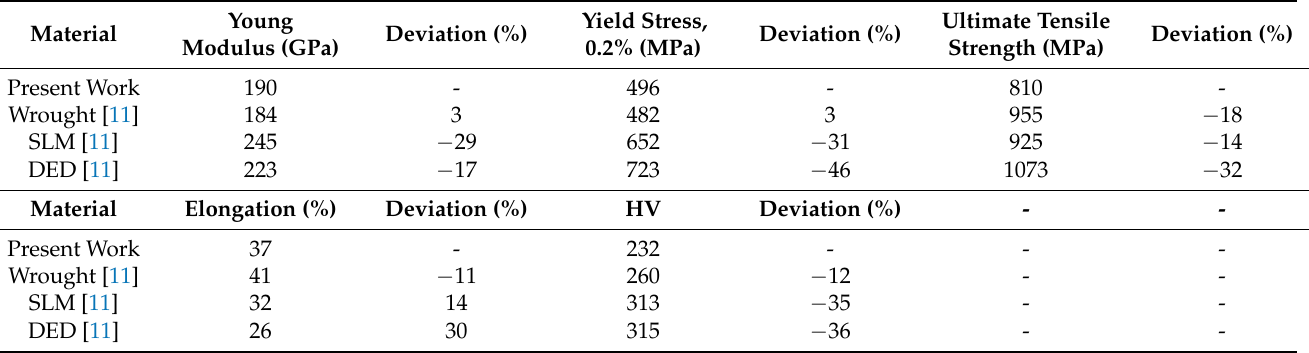
Table 3. Comparison of tensile and hardness properties.